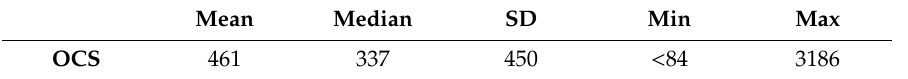
Table 2. Distribution of octachlorostyrene (OCS) levels (pg g-lipid − 1 ) among participants ( N = 100). Mean Median SD Min Max OCS 461 337 450 < 84 3186